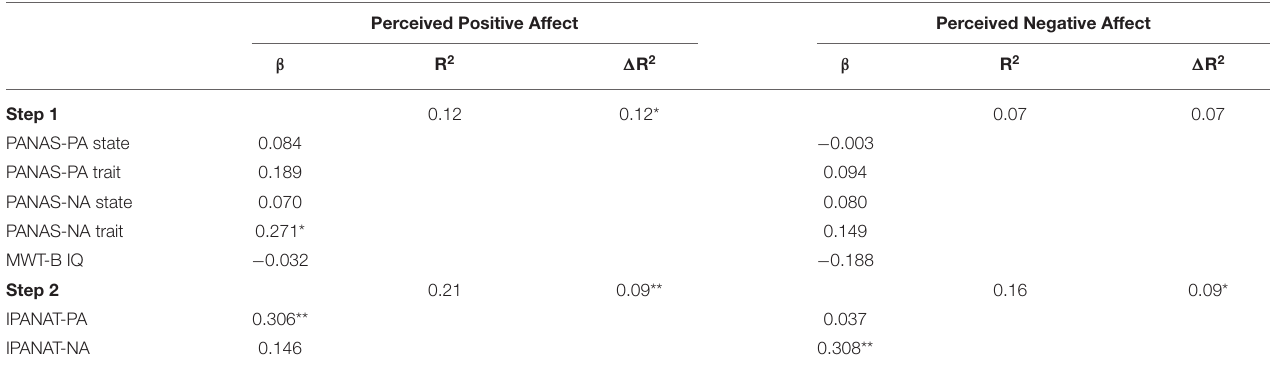
TABLE 2 | Hierarchical multiple regression analyses with perceived affect in the PFE task as dependent variables and affect measures and MWT-B as